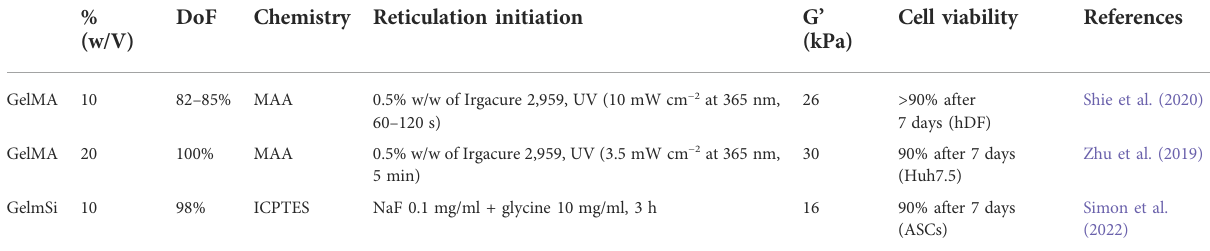
TABLE 3 Comparison between GelMA and GelmSi